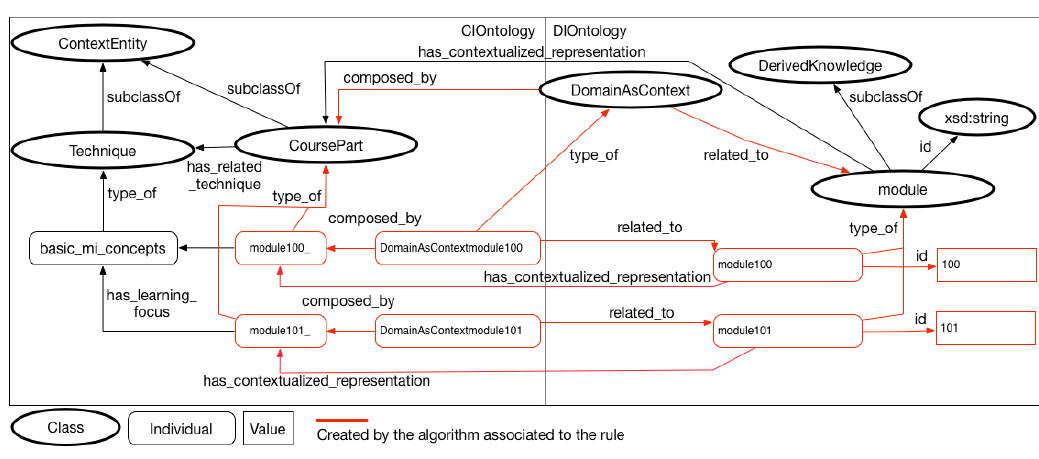
Figure 2. Ontology fragment after the creation of domain and context linking rule